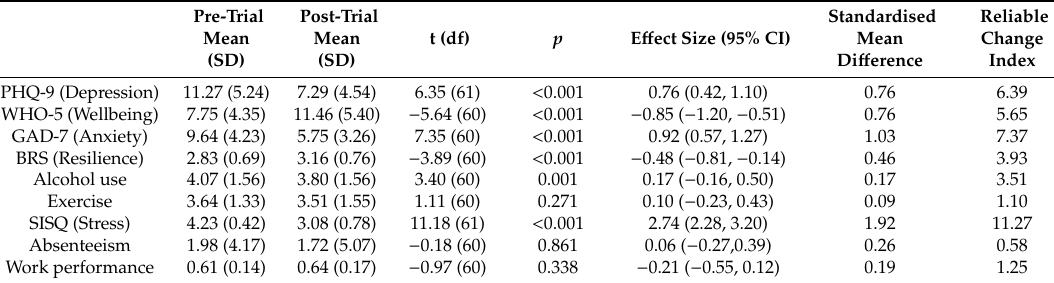
Table 2. Change in outcome scores over